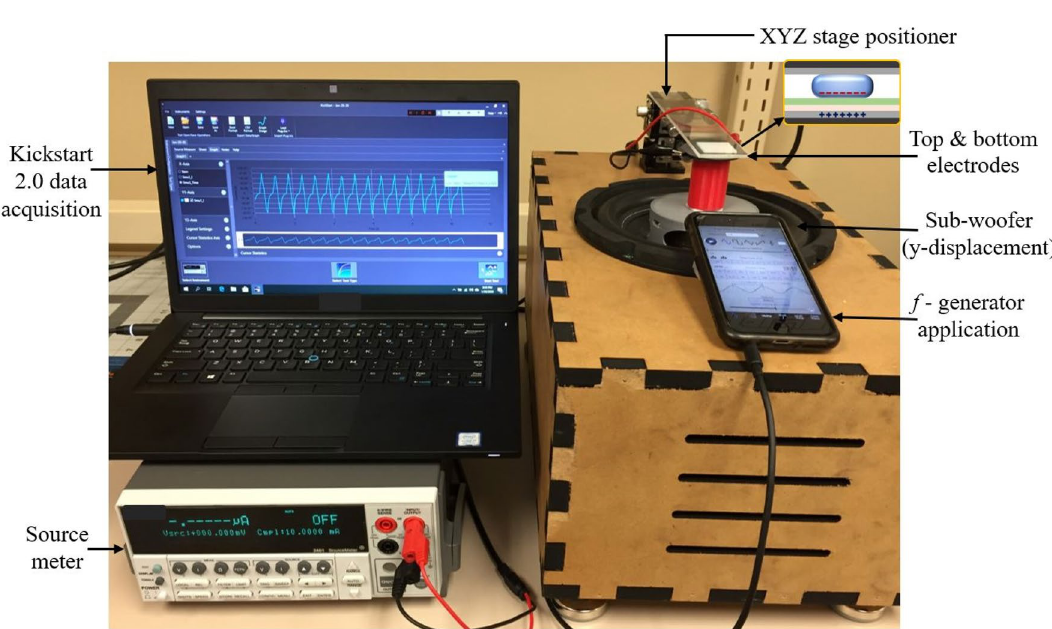
Figure 5. Measurement set-up for REWOD energy harvesting. Electrolyte modulation between the two dissimilar electrodes is shown in the